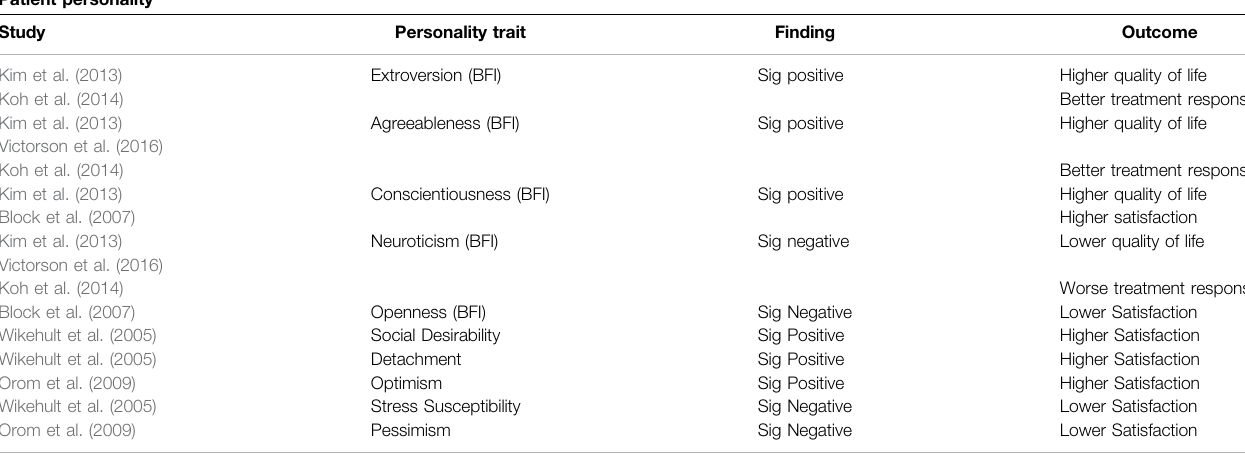
TABLE 2 | Summary of patient ’ s personality traits on health-care-related outcomes.